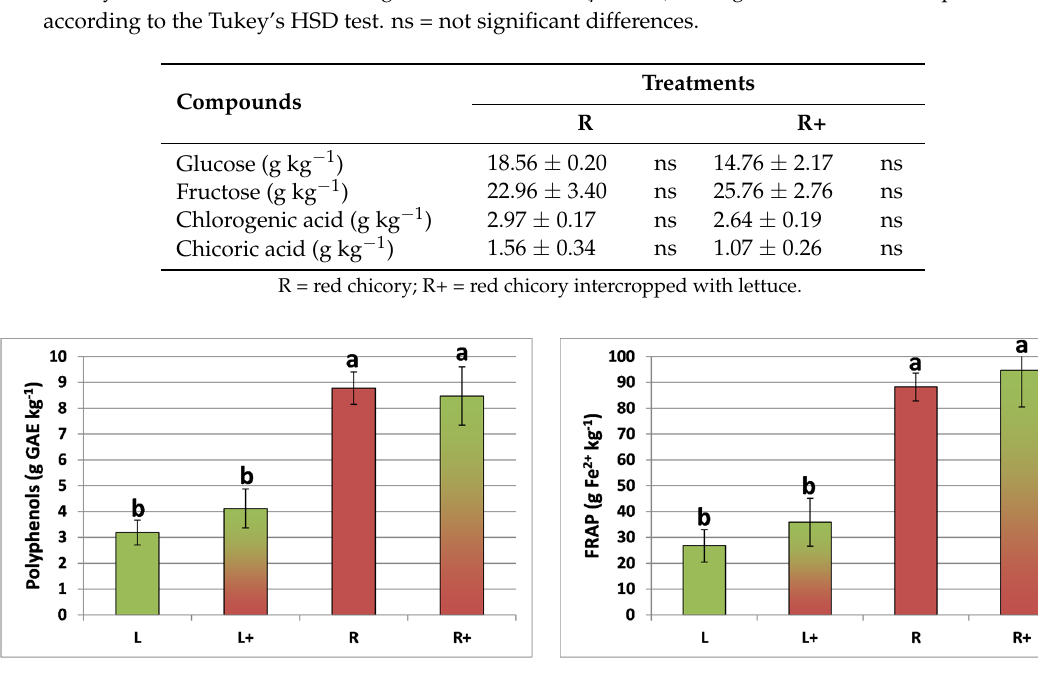
Figure 2. Total phenol content and antioxidant activity (FRAP) measured in lettuce and red chicory in three experimental treatments. L = lettuce; L+ = lettuce intercropped with red chicory; R = red chicory; R+ = red chicory intercropped with lettuce. Different letters (a, b) indicate significant differences ( p < 0.01) among treatments for each parameter, according to the Tukey’s HSD test.